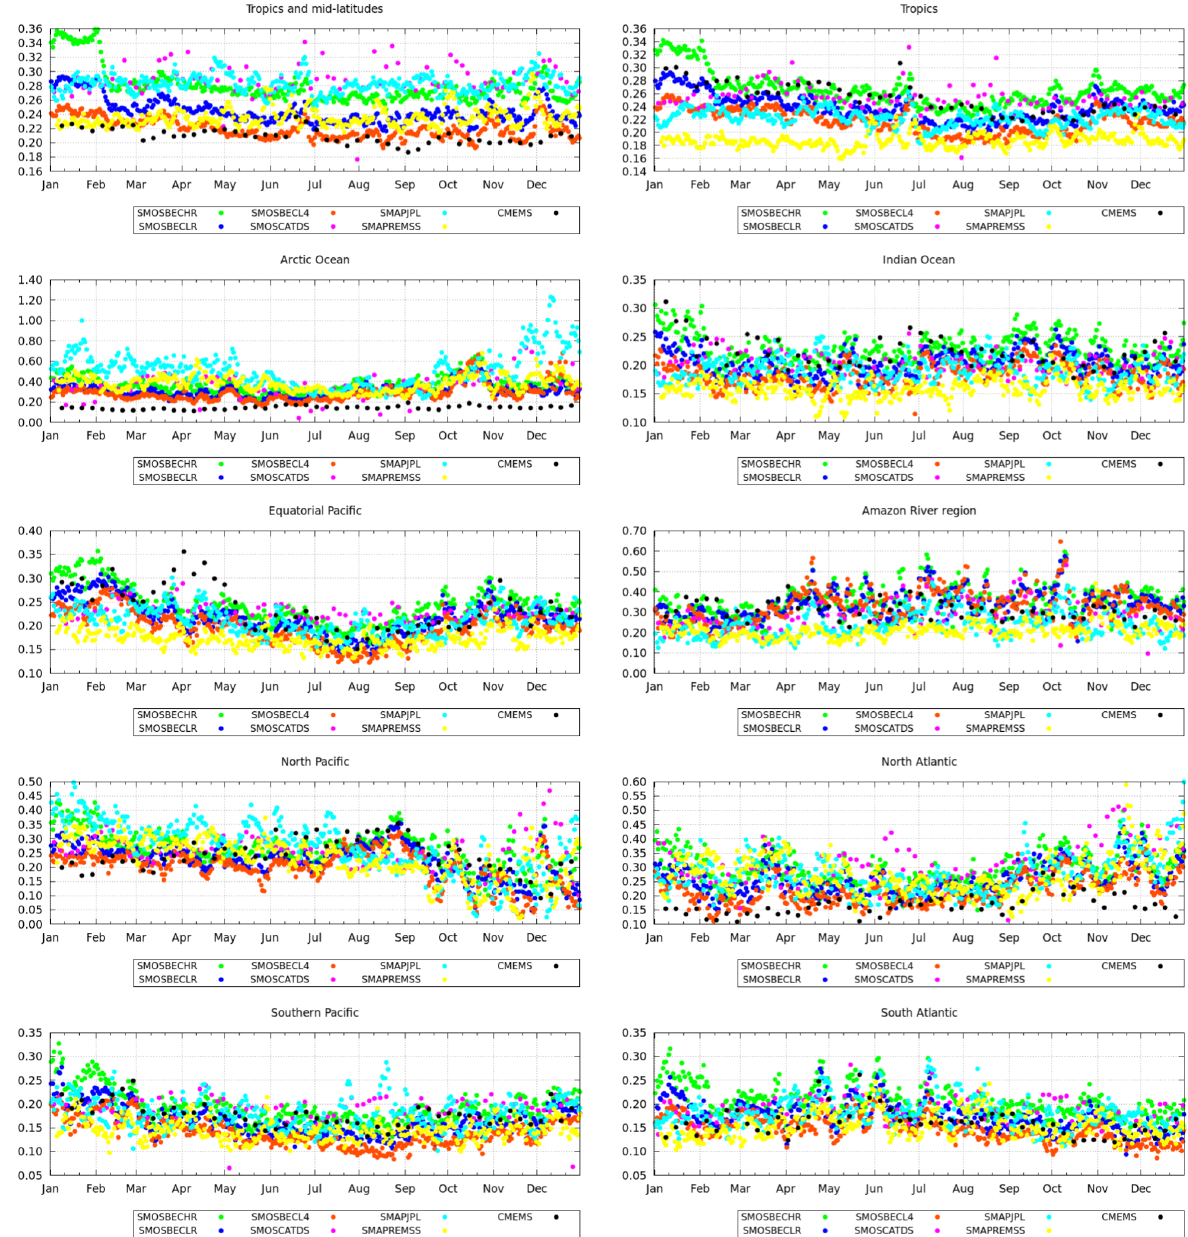
Figure 11. Standard deviation of the differences between the gridded SSS products and Argo salinity in different ocean regions for the year